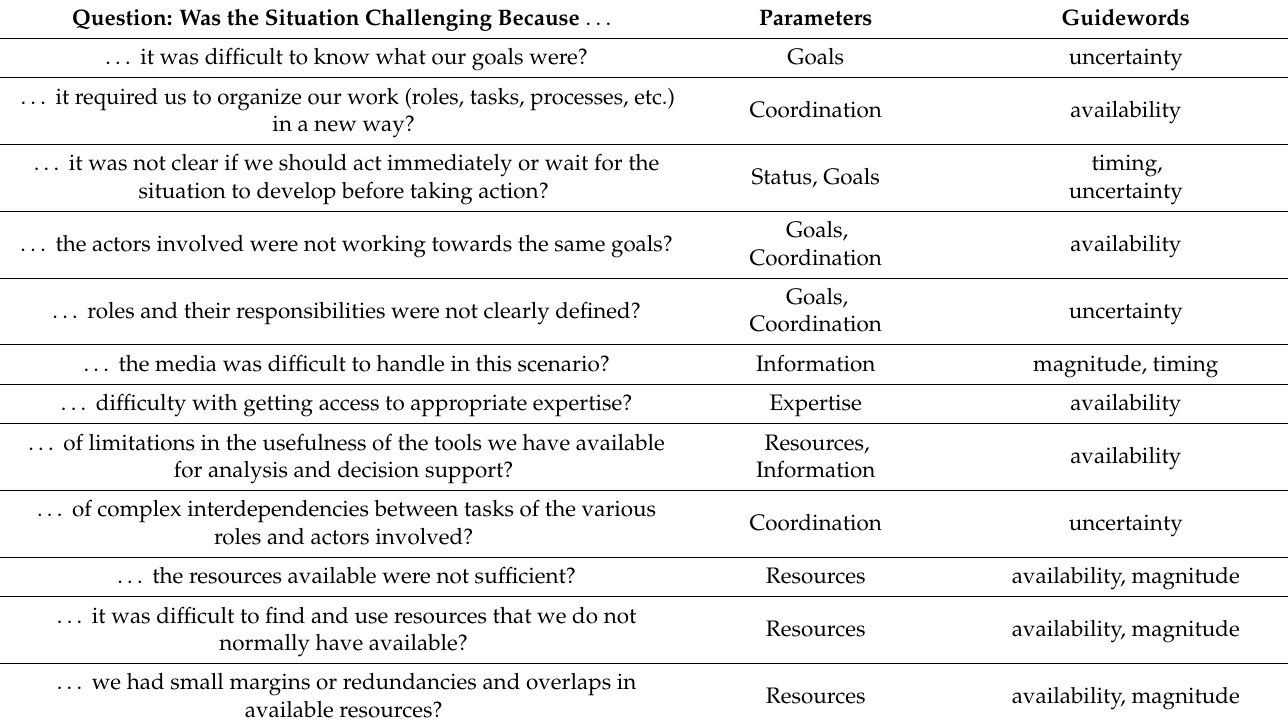
Table 4. Parameters, guidewords, and active verbs transformed into example questions exploring the solution space (response